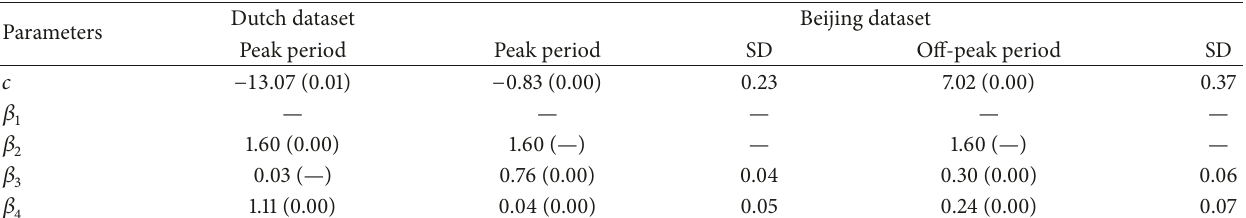
Table 7: Model parameters in the different datasets.